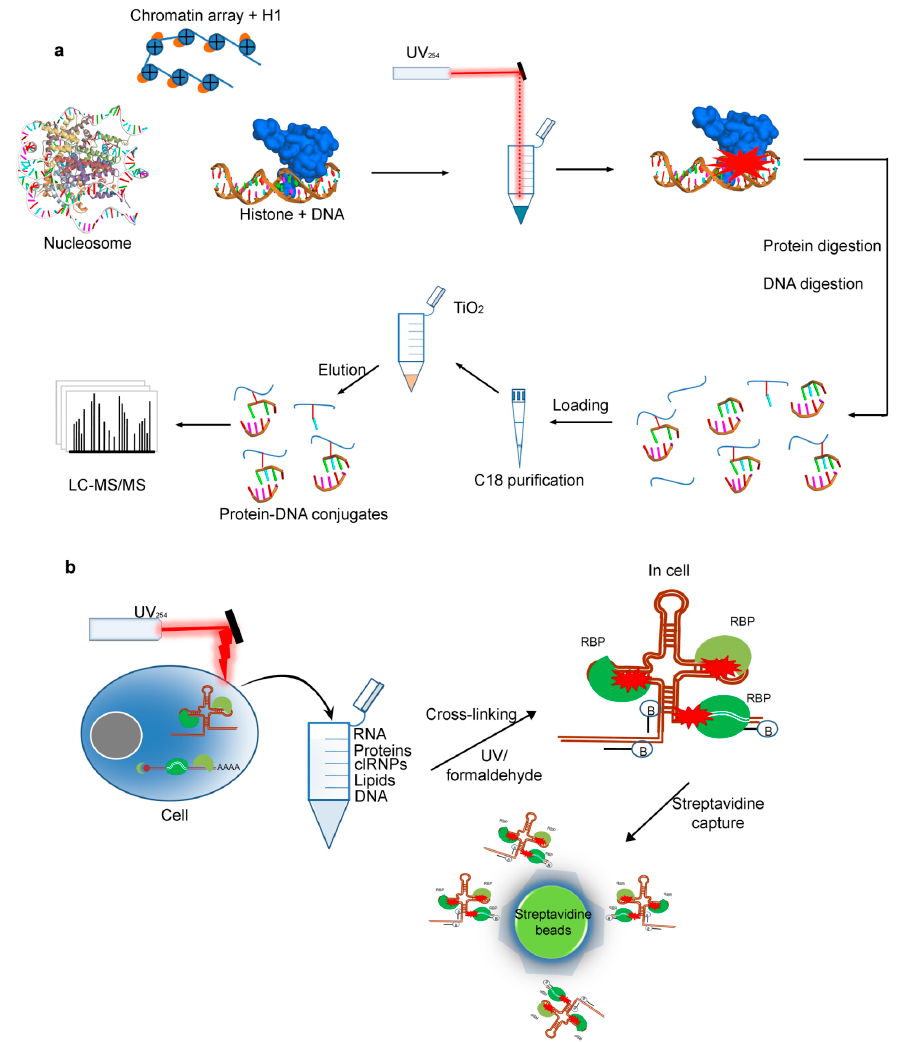
Figure 6. Schematic outline of the CLMS technique, to probe protein- DNA /RNA interactions. ( a ) Workflow for mass spectrometry analysis of UV-induced cross-links in histone-DNA complexes, nucleosomes, and chromatin arrays [140,159]. ( b ) Cross-linking based methods use either UV (RAP, RNA affinity purification; PAIR, peptide-nucleic acid assisted identification of RNA-binding proteins; MS2-BioTRAP, MS2 in vivo biotin-tagged RAP; and TRIP, tandem RNA isolation procedure) or formaldehyde cross-linking (CHART, capture hybridization analysis of RNA targets; ChIRP, Chro- matin Isolation by RNA Purification) to capture RNA–protein interactions. Biotinylated oligonucleotide probes are hy-